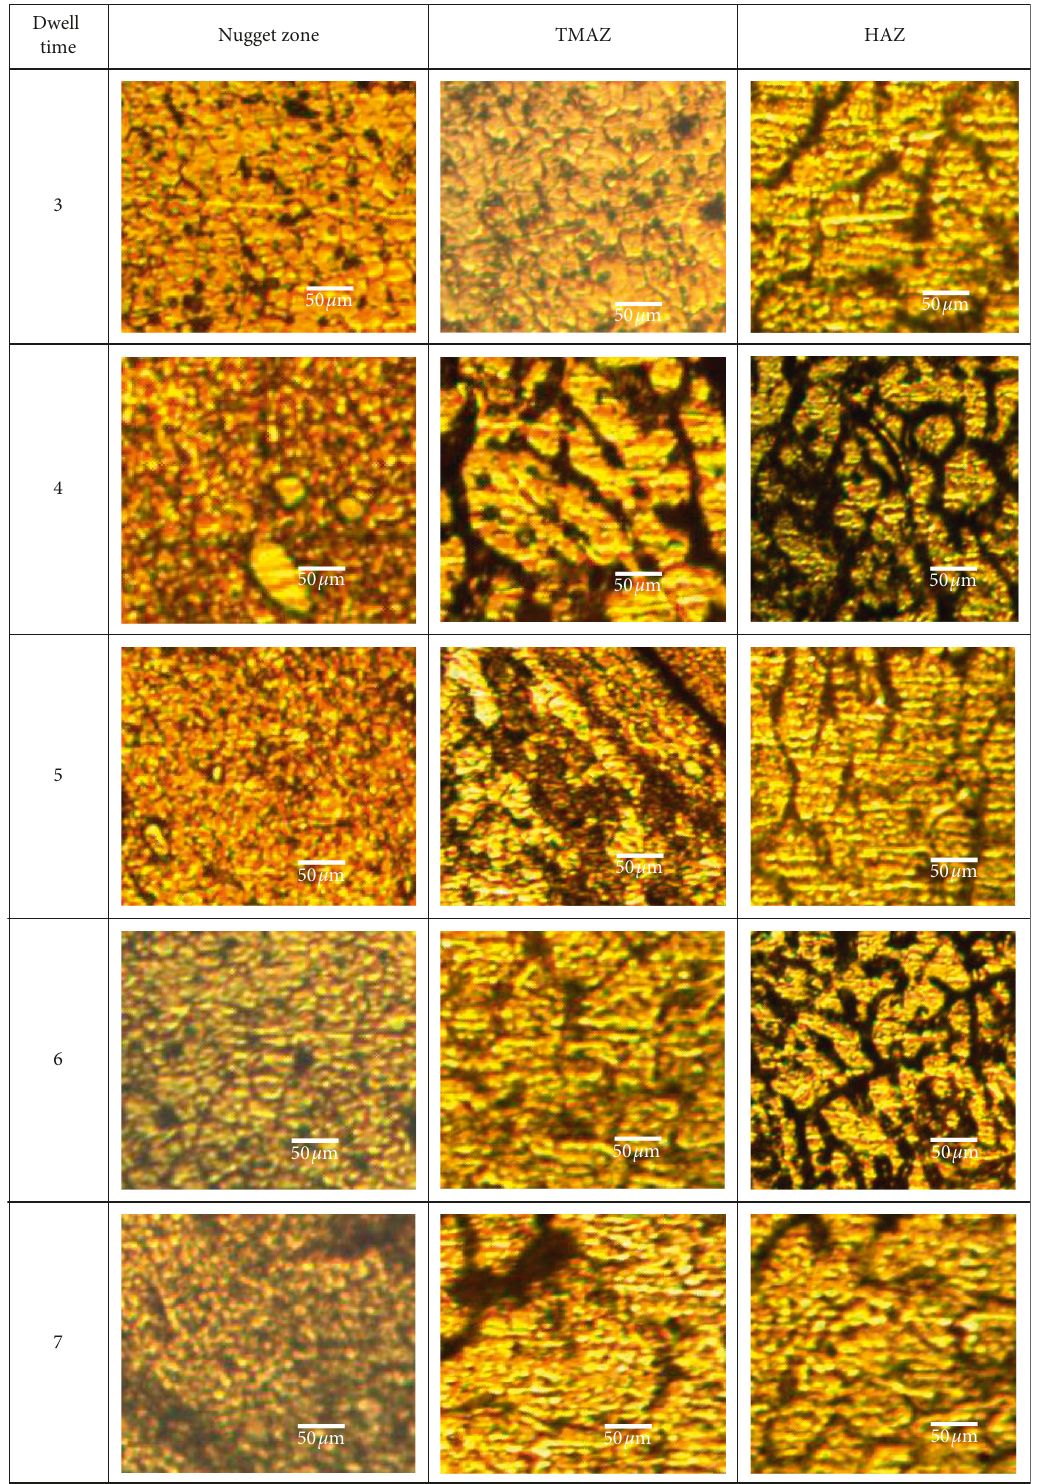
Figure 3: Influence of dwell time on microstructure of FSSW